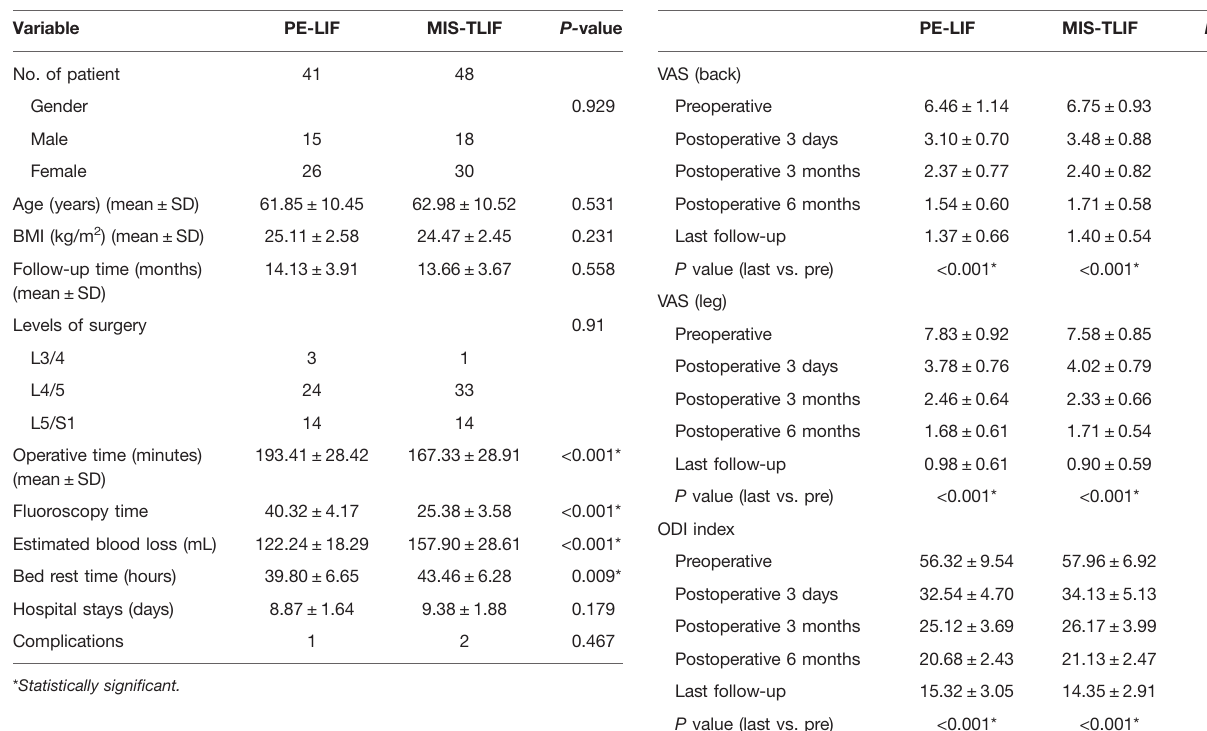
TABLE 1 | Demographics and baseline characteristics of the two groups: PE-LIF versus MIS-TLIF.